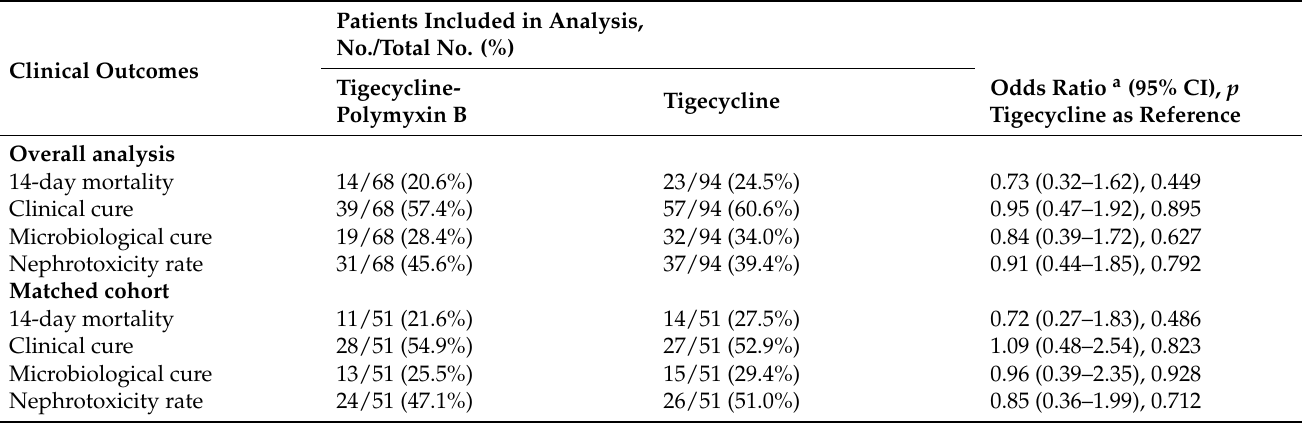
Table 2. Clinical outcomes in patients with nosocomial pneumonia caused by carbapenem-resistant A. baumannii or K. pneumoniae .